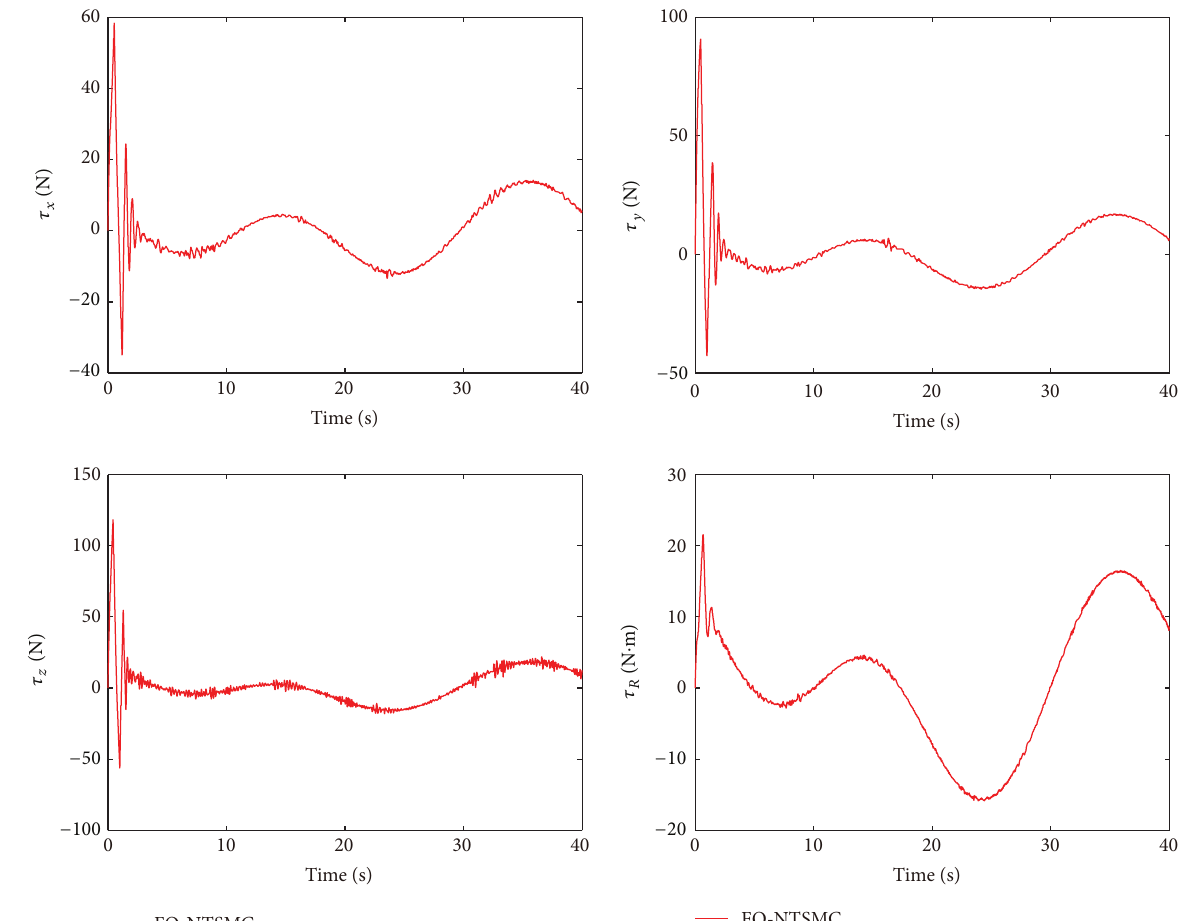
Figure 16: Control inputs of output feedback FO-NTSMC with boundary